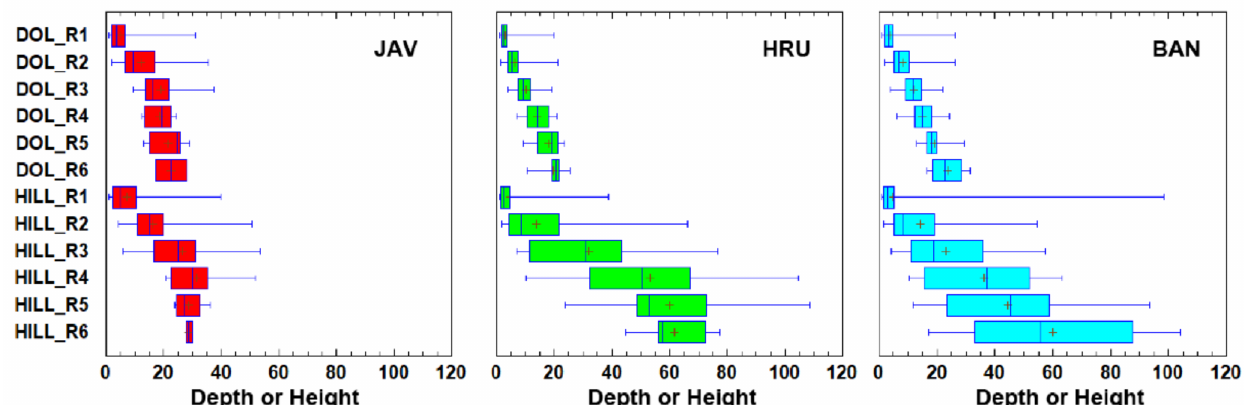
Figure 10. Box-whisker plots of doline depths and hill heights. The plus signs denote the mean values of the distributions. The boxes mark the ranges between the lower and upper quartiles. JAV: Javorniki; HRU: Hrušica; and BAN: